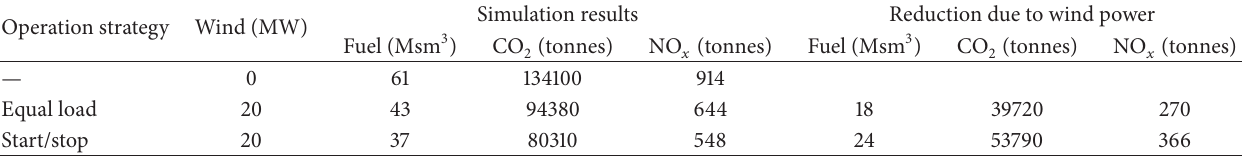
Table 2: The simulated yearly fuel consumption and emissions.